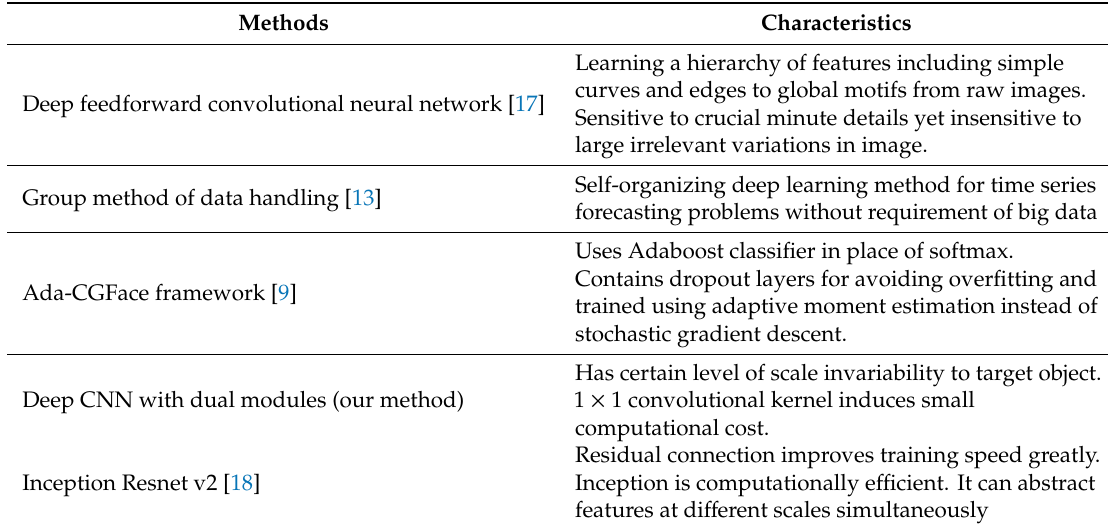
Table 1. Comparison of Deep Learning Methods. Methods